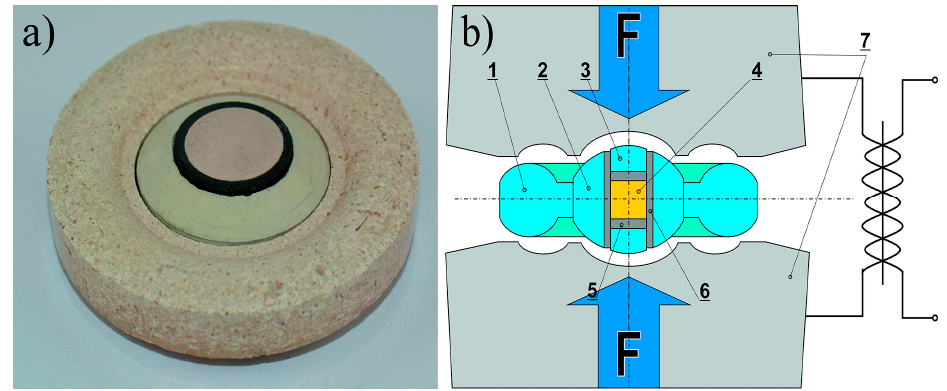
Figure 2. View of the high-pressure gasket assembly ( a ); cross-section diagram of the sintering process ( b ): 1—ceramic gasket (outer part); 2—ceramic gasket (inner part); 3—ceramic disc; 4—sample; 5—graphite disc; 6—graphite tube; 7—sintered carbide dies. Table 1. Conditions of sintering in HP